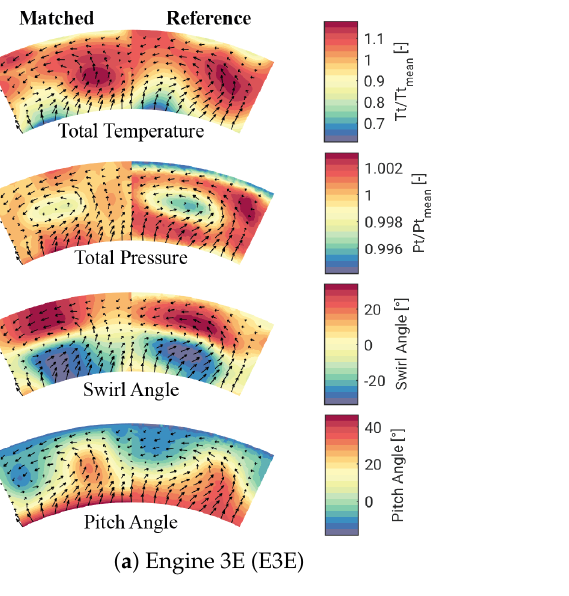
Figure A3. Results of additional lean burn test cases.